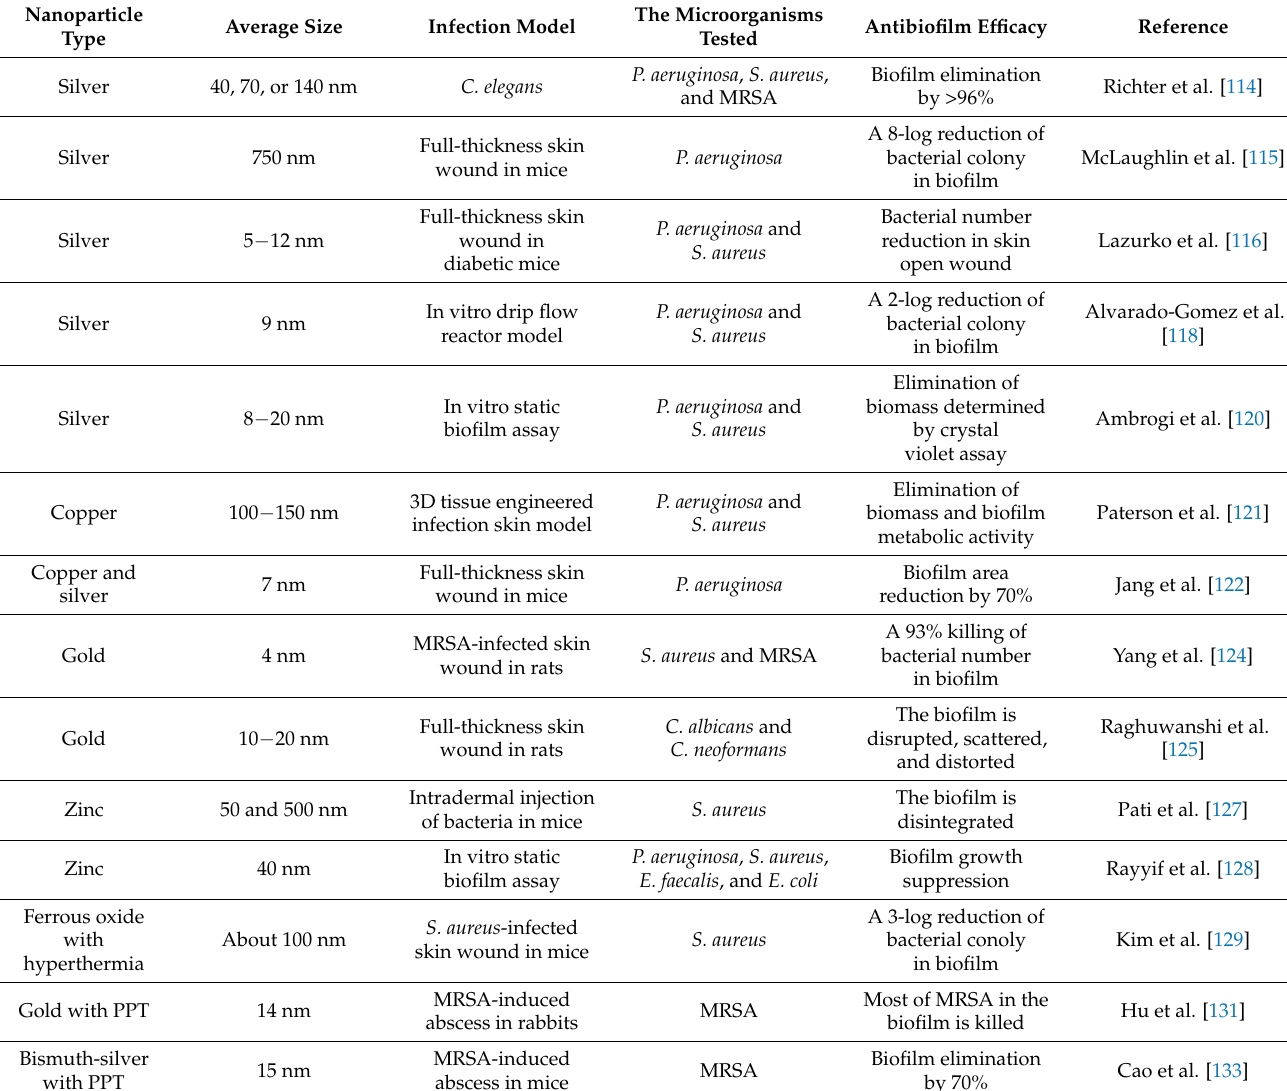
Table 2. The application of metallic nanoparticles for antibiofilm